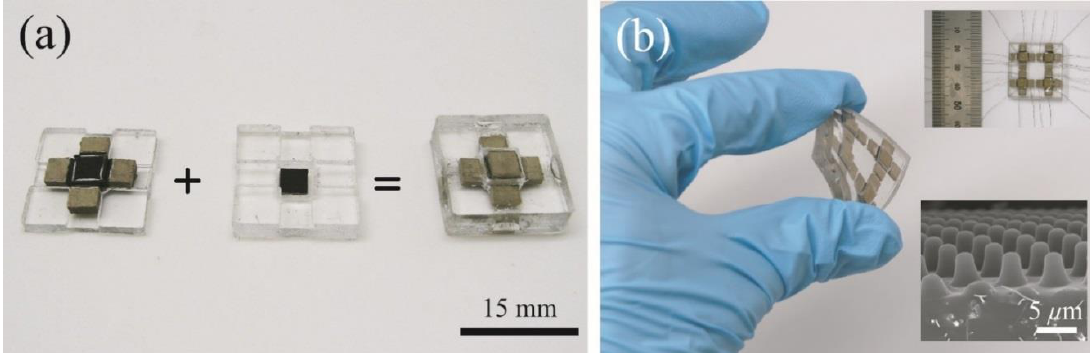
Figure 3. Photographs and scanning electron microscopic (SEM) image of the fabricated sensors ( a ) the bottom housing with the central core and four sidewall structures is assembled with the top housing to construct a sensor; ( b ) a 2 × 2 array sensor shows its flexibility. The embedded sensor image with a ruler shows the electrical lines inserted in the conductive polymer blocks. The embedded SEM image shows the surface of a CNT/PDMS composite film with microdome